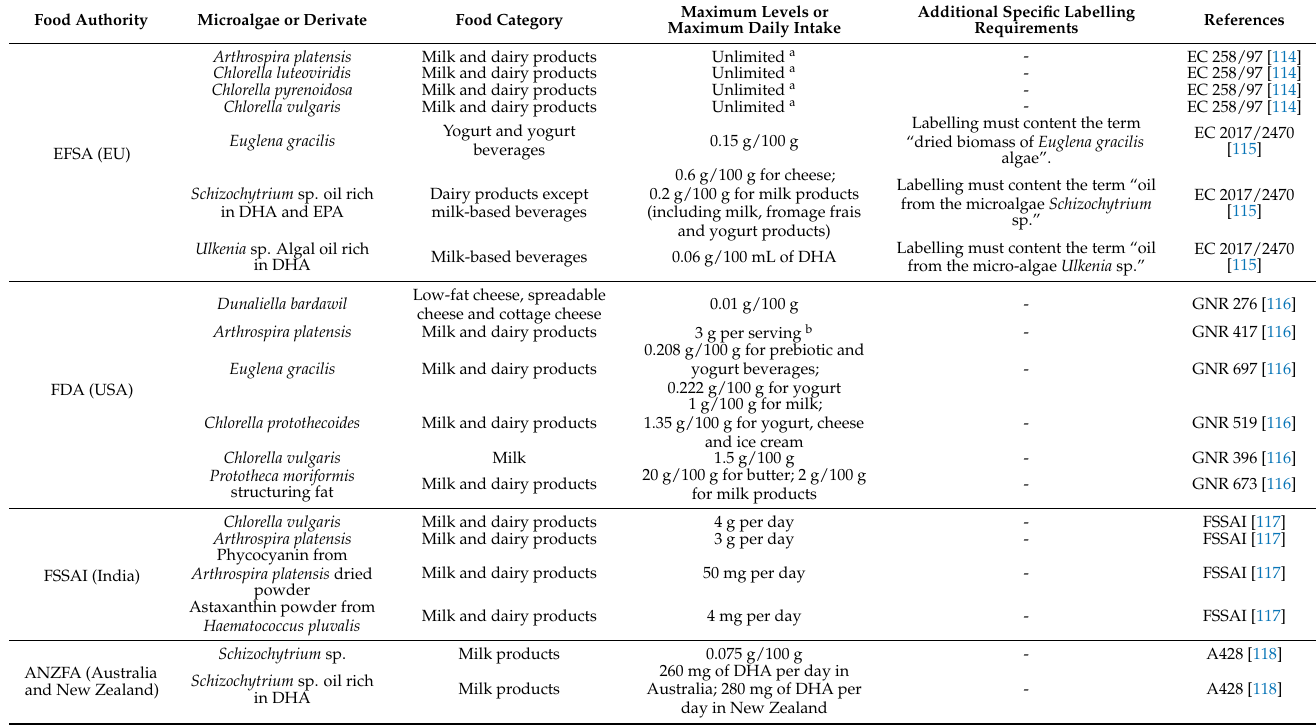
Table 5. Microalgae or derivates approved for adding in milk and dairy